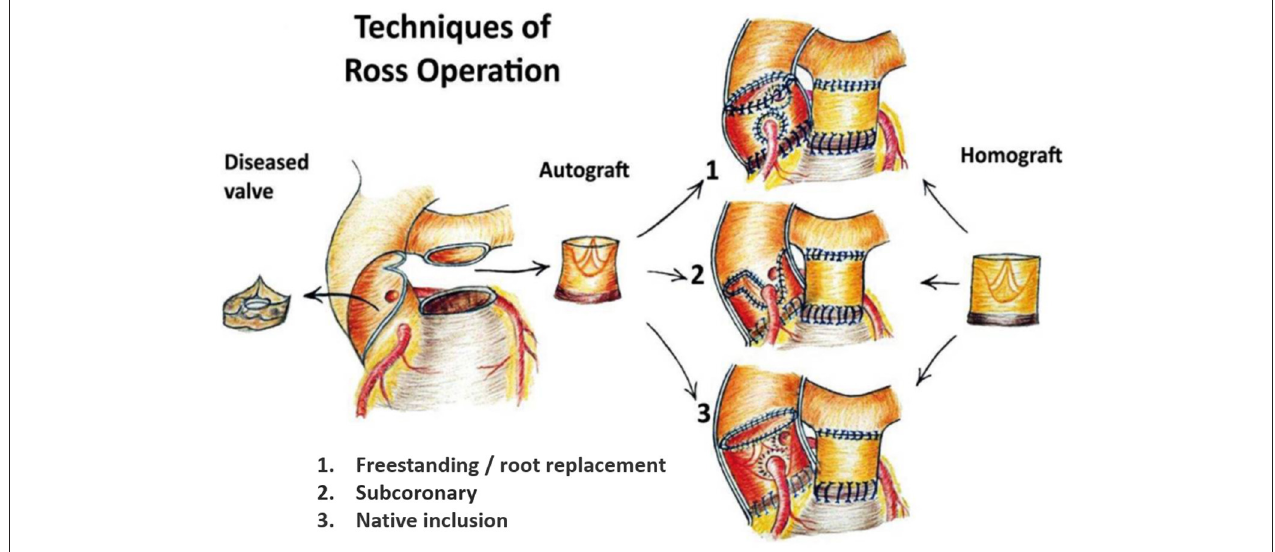
FIGURE 1 | The 3 main techniques of the Ross procedure. 1. Freestanding root replacement technique with implantation of the entire pulmonary root into the left ventricular outflow tract. 2. Subcoronary technique: implantation of the pulmonary valve only within the native aortic annulus. 3. Autologous/native inclusion technique with implantation of the pulmonary autograft within the native aortic wall to prevent dilatation. Figure reproduced from Sievers ( 4), journal ceased publication no permission could be requested.